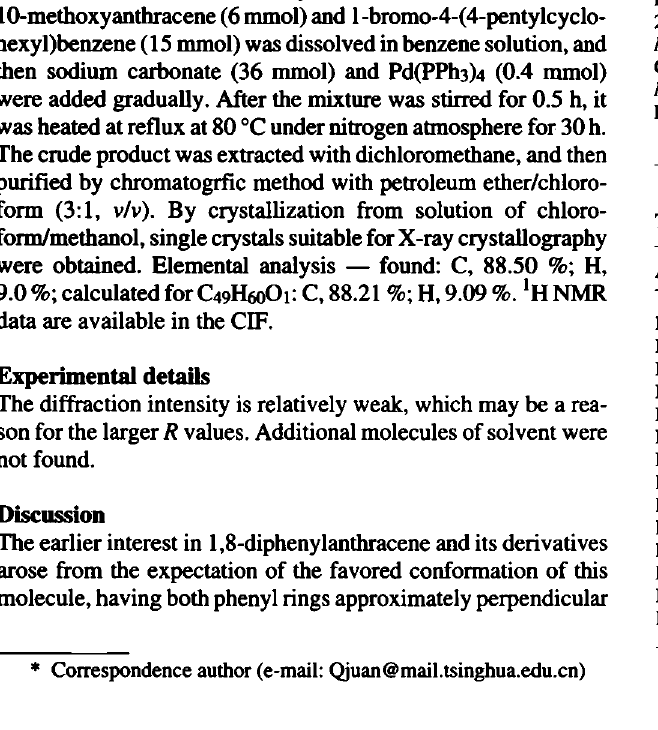
Table 2. Atomic coordinates and displacement parameters (in Â 2